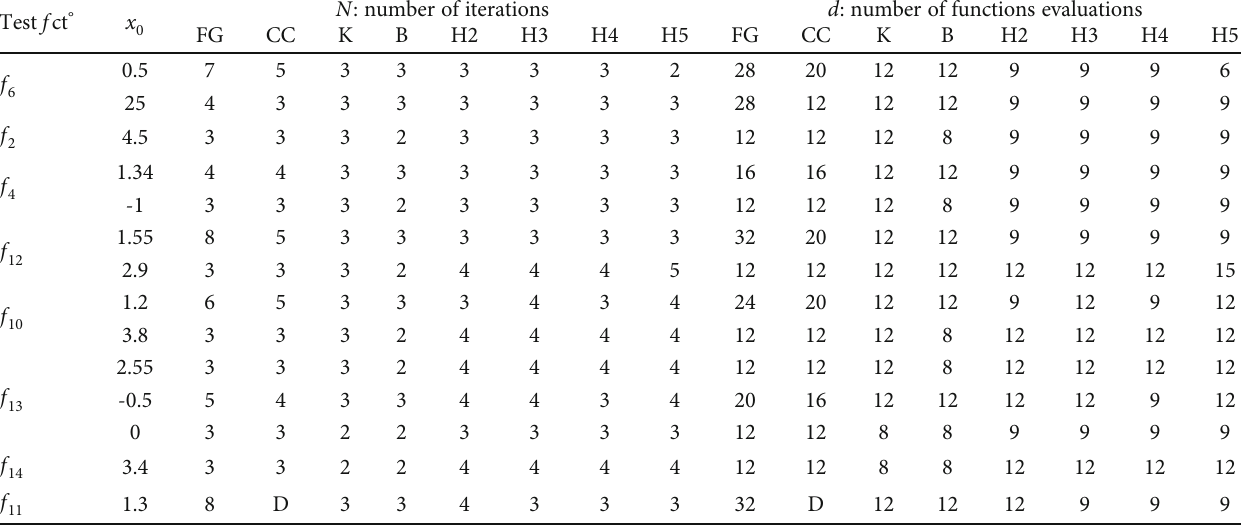
Table 4: Comparison of methods of various orders in terms of the number of iterations and number of functions evaluations. Test f ct